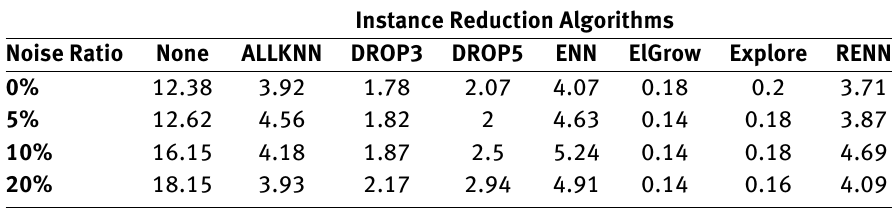
Table 11: Average Tree Size for unpruned trees at different noise ratios Instance Reduction Algorithms